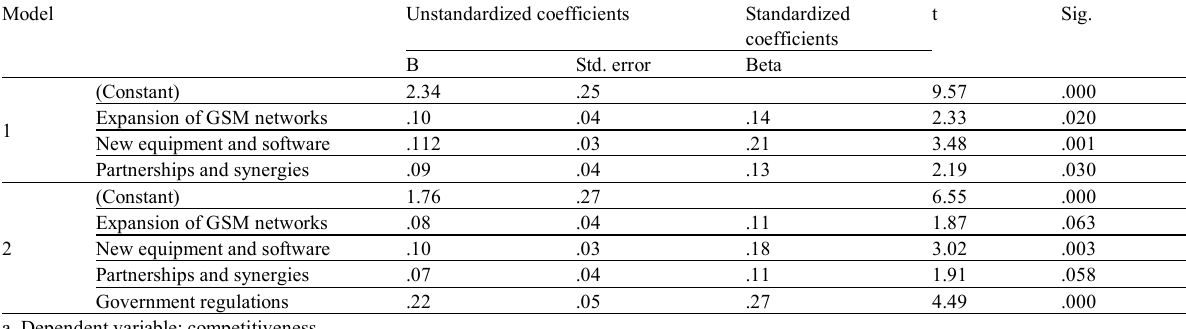
Table 3: Coefficients of technological innovation on competitive